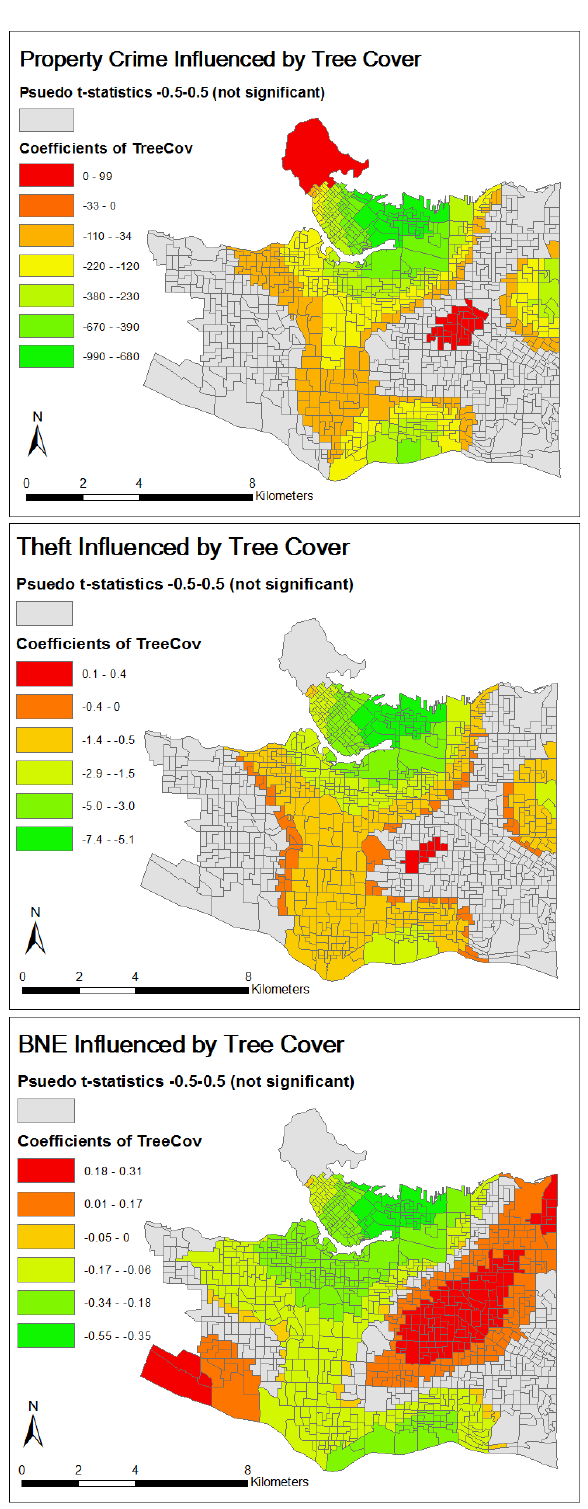
Figure 4. GWR maps showing spatial variation of the local tree coverage